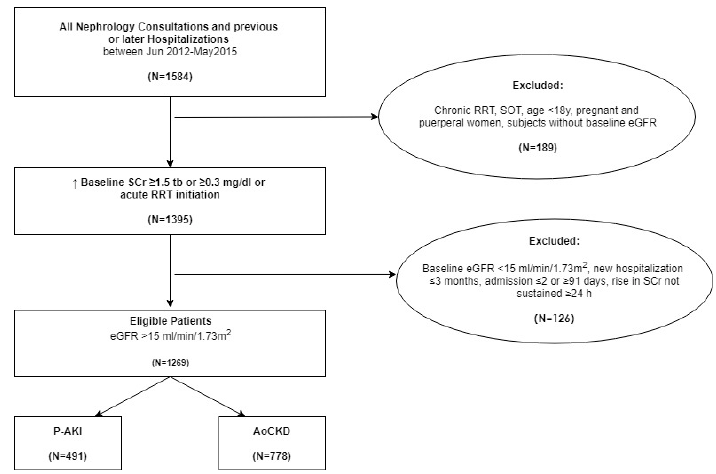
Figure 1. Study flow chart for inclusion and exclusion criteria. RRT: Renal replacement therapy; SOT: Solid organ transplantation; Tb: Times baseline. SCr: Serum creatinine; eGFR: Estimated glomerular filtration rate; P-AKI: Pure acute kidney injury; AoCKD: Acute on chronic kidney disease.